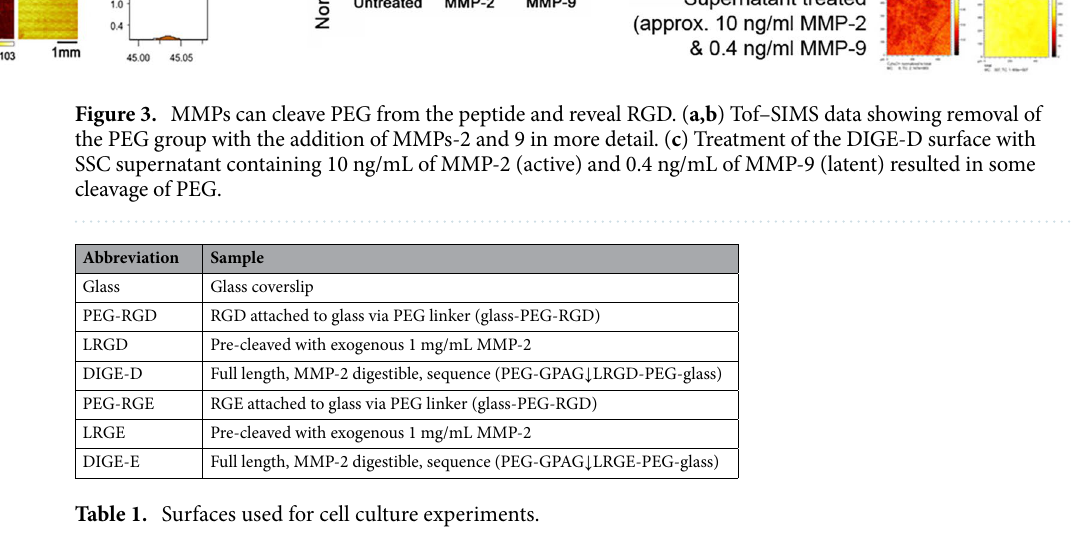
Table 1. Surfaces used for cell culture